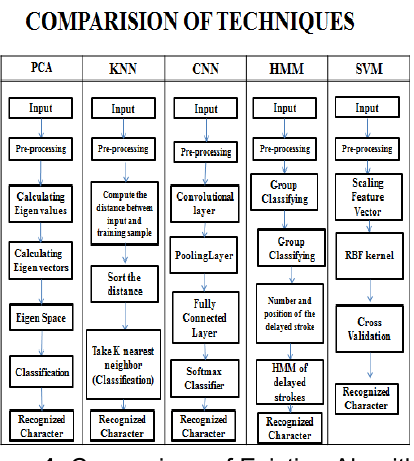
Figure 1. Comparison of Existing